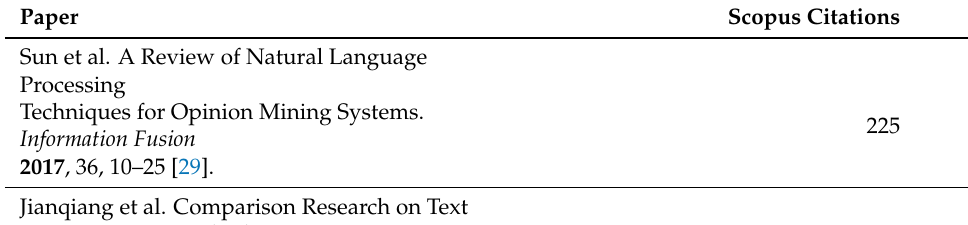
Table 1. Four relevant papers on text pre-processing indexed by